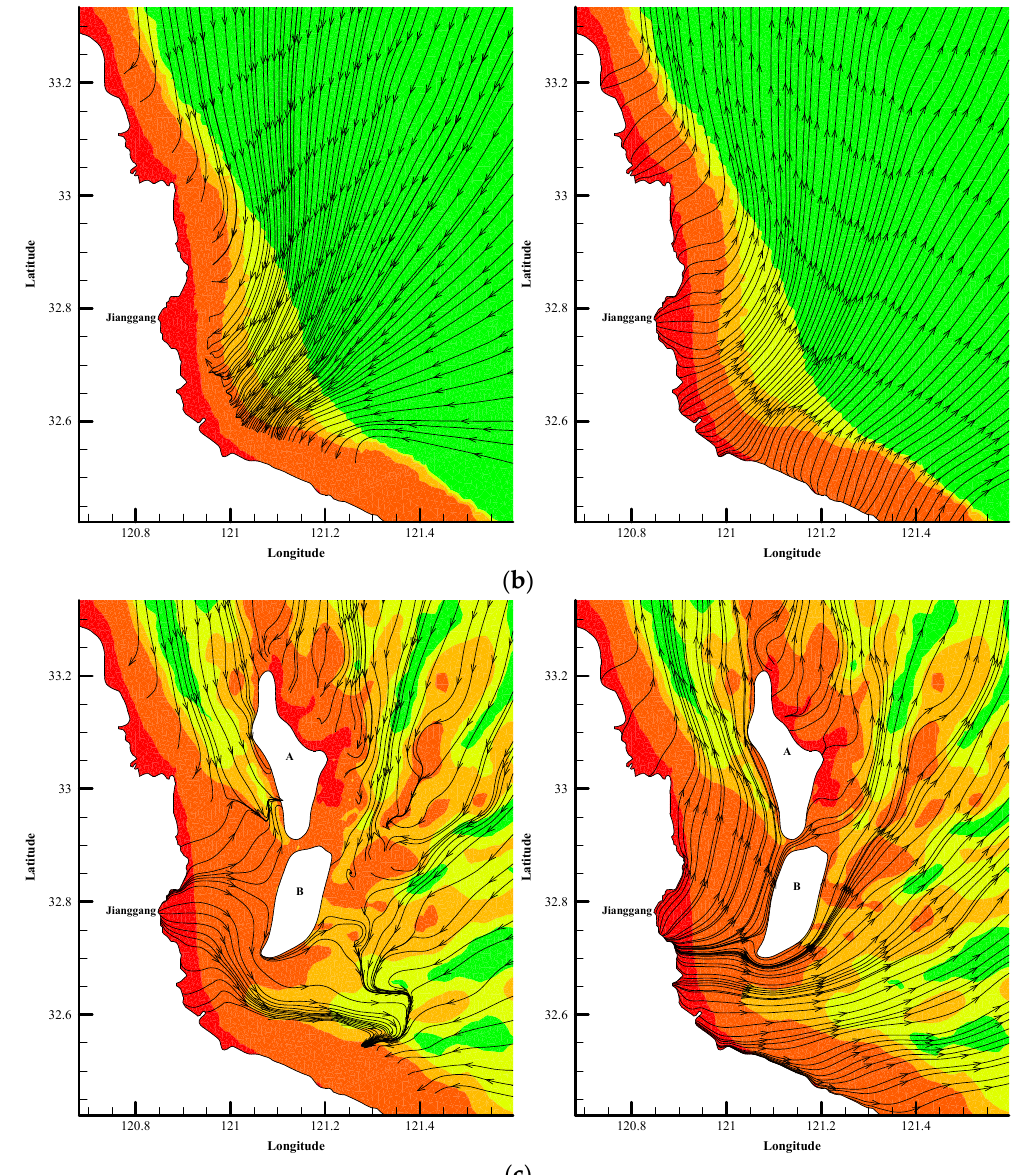
Figure 11. The tidal current streamlines in the local area (the base map shows the topography); ( a ) Maximum flood and ebb streamlines when the natural RSRs are present; ( b ) Maximum flood and ebb streamlines when there are no RSRs; ( c ) Maximum flood and ebb streamlines when the RSRs are partially reclaimed.